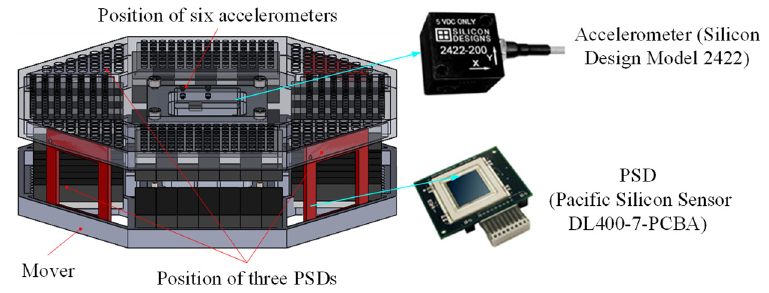
Figure 8. Accelerometers and PSDs on the mover.